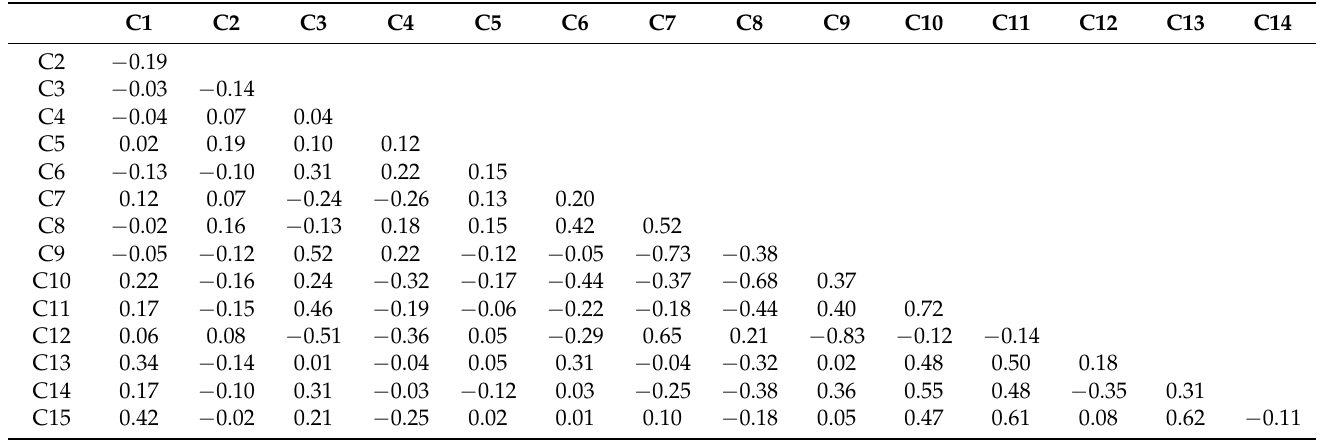
Table 5. Calculated Pearson Correlation (r) for each pair of